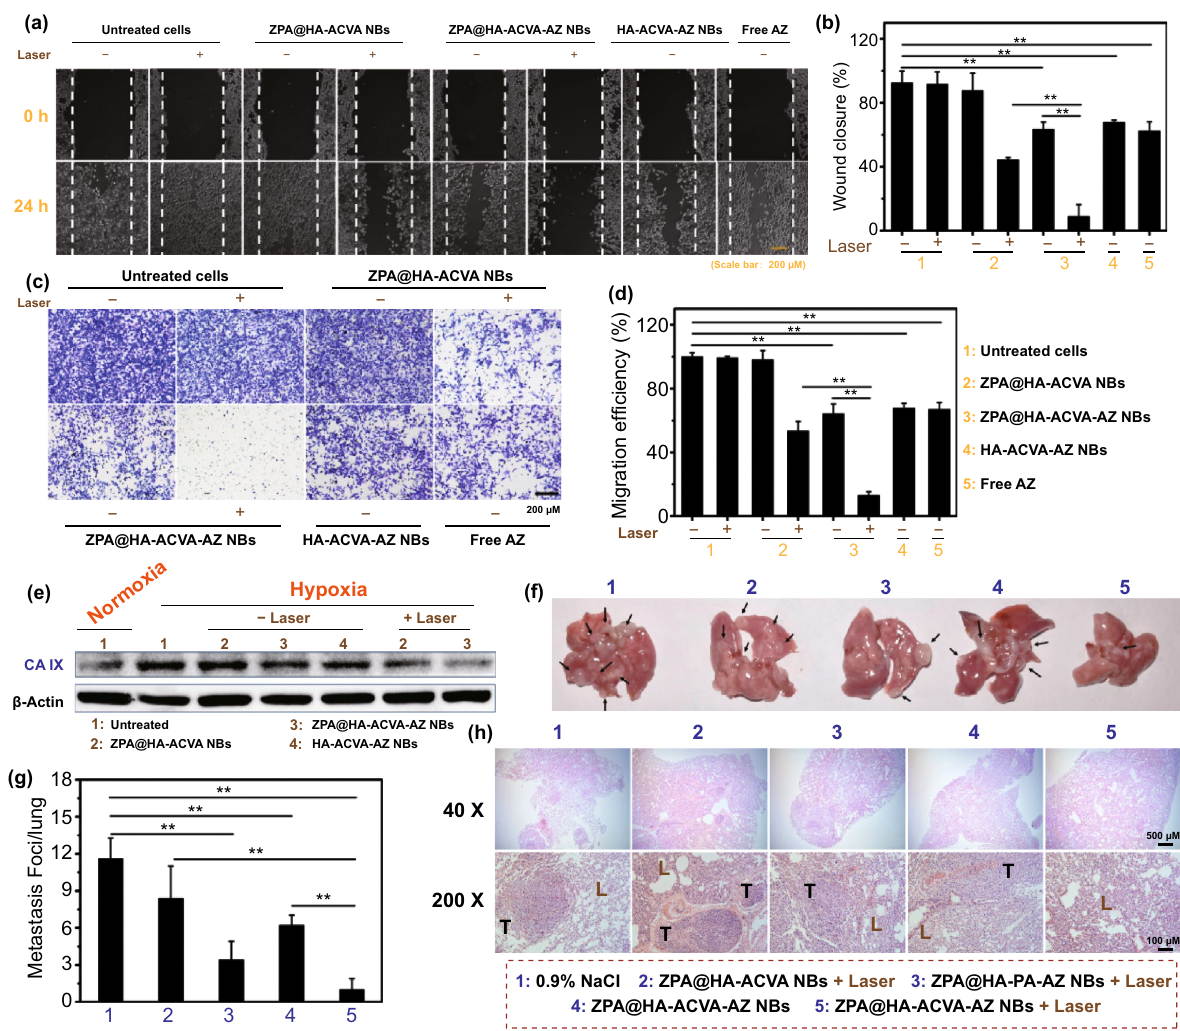
Fig. 5 Lung metastasis inhibition from breast cancer by ZPA@HA-ACVA-AZ NBs. a Wound-healing ability, b wound closure efficiency, c transwell capacity, d transwell migration efficiency and e CA IX expression of 4T1 cells treated with varying drug formulations with or without 808-nm laser irradiation (1 W/cm 2 , 10 min). f Morphology, g metastasis foci and h H&E images of lungs from mice bearing 4T1 tumor injected with varying drug formulations with or without laser irradiation at a wavelength of 808 nm (1 W cm −2 , 5 min) (n = 5). Black arrows in f repre- sent the foci of tumor metastases. T and L in h represent the tumor and lung,